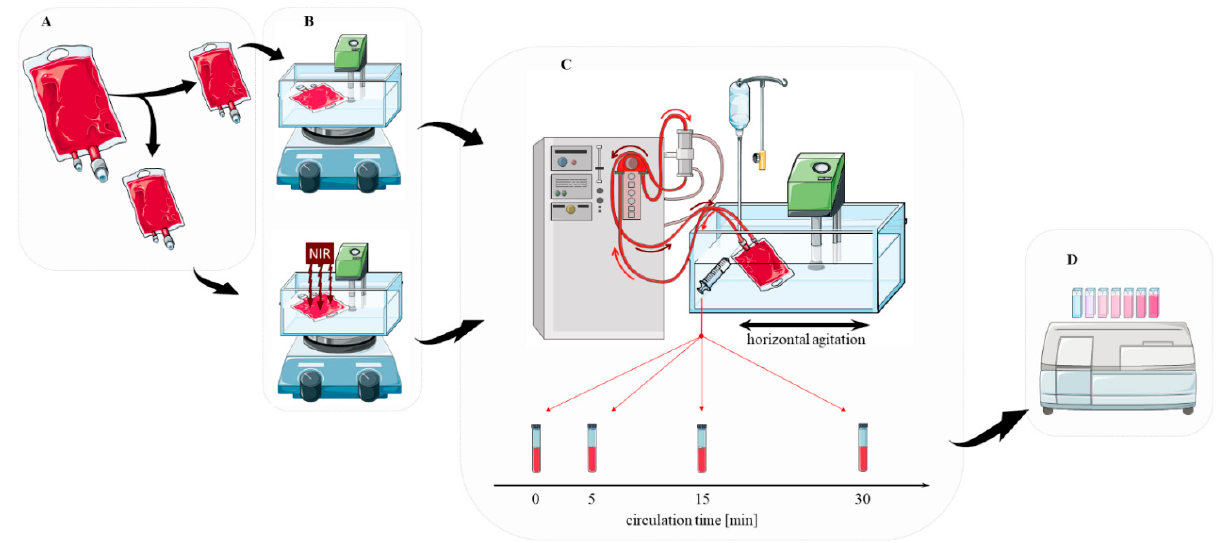
Figure 1. The concept of an experimental procedure. The blood was divided into two identical parts ( A ) followed thermal stabilization at 37 °C with or without exposition to NIR ( B ). CTR or NIR irradiated blood was introduced into the extracorporeal circuit of the HD machine and circulated for 30 min ( C ). Blood samples were taken at different time points for biochemical and biophysical analyses ( D ). Note: This figure contains graphic elements modified from Servier Medical Art (http://smart.servier.com/, accessed on 22 March 2022), licensed under a Creative Common Attribution 3.0 Generic License.